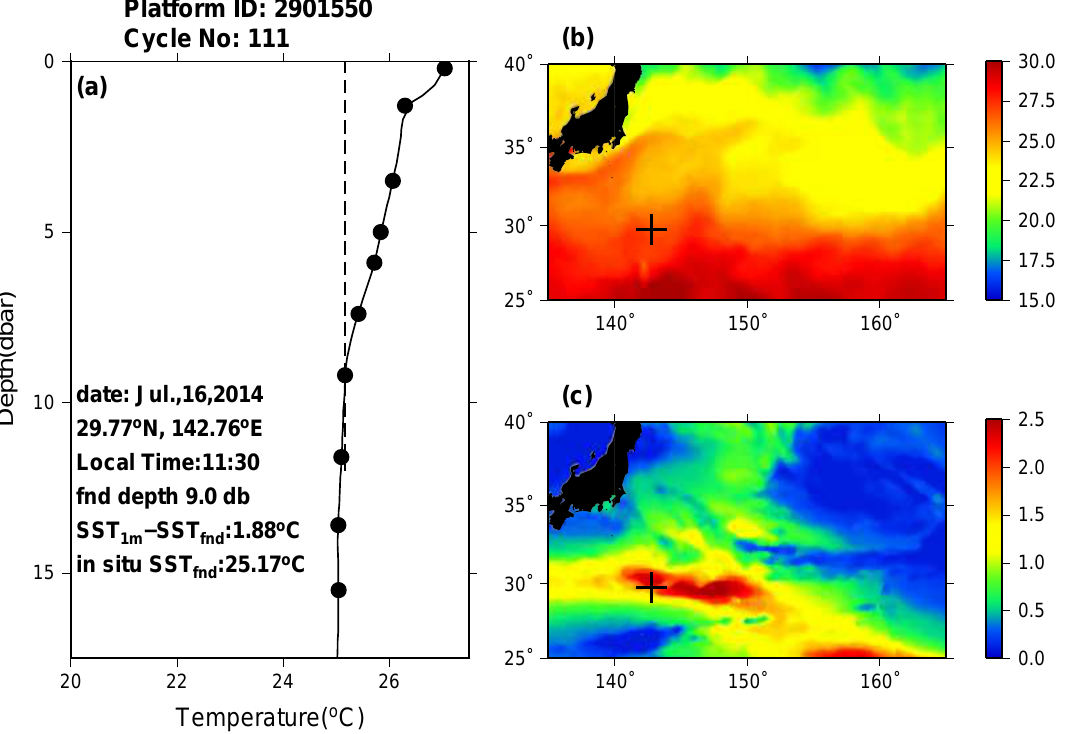
Figure 2. ( a ) Example of Argo near-surface profiling data and the determination of foundation SST by this study. Black dots represent observations by Argo float, and the solid line is the line interpolated by the Akima method from the observations. The dashed line denotes the foundation sea surface temperature (SST) determined from the observation. The difference between the foundation SST and 1-m depth SST was 1.88 ◦ C. ( b ) Satellite-based foundation SST field of this study. ( c ) Same as ( b ), but for the daily maximum minus minimum SST estimated from the sea surface wind (SSW) and solar radiation data. Cross points in ( b ) and ( c ) corresponded to the Argo